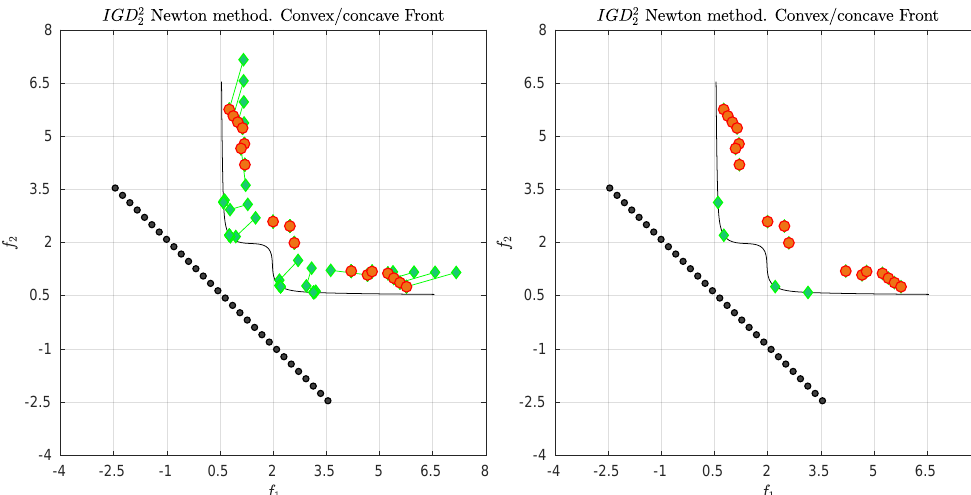
Figure 10. ( Left ) application of the IGD 2